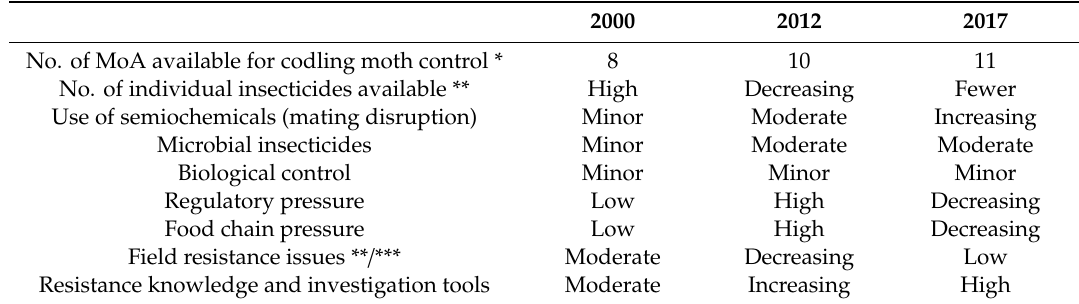
Table 3. Changes in codling moth control from 2000 until now (modified according to IRAC